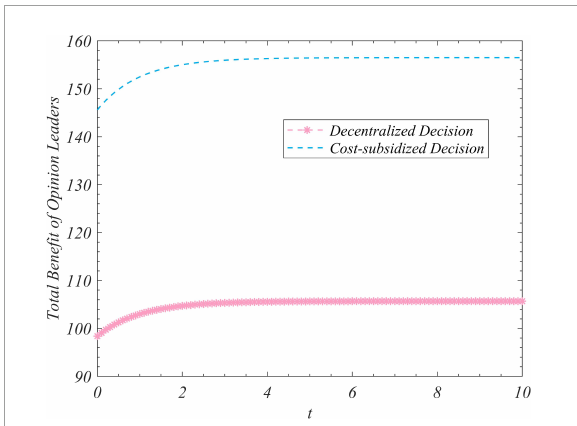
FIGURE3 Trends of the total income of opinion leaders under the decentralized and subsidized decision-making scenarios.